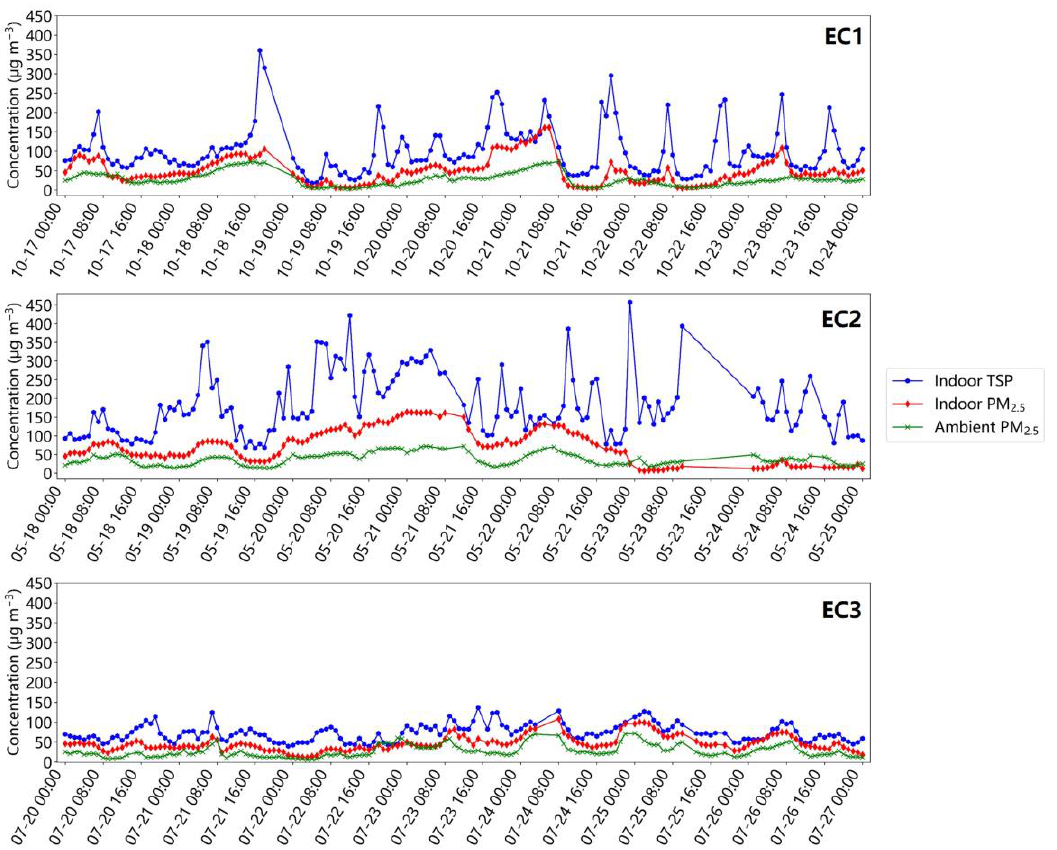
Figure 4. A week diurnal change of indoor TSP, PM 2.5, and ambient PM 2.5 concentrations under three ECs. Table 3. Indoor TSP and PM 2.5 concentrations at daytime and nighttime in three ECs.